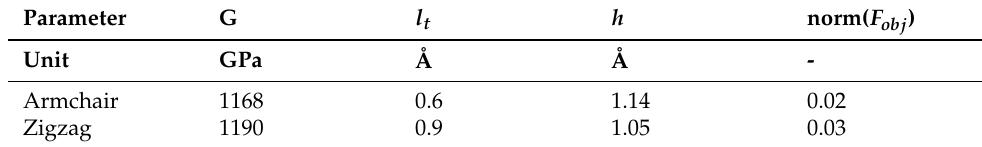
Table 3. Identified material parameters for armchair and zigzag CNTs as couple stress materials.